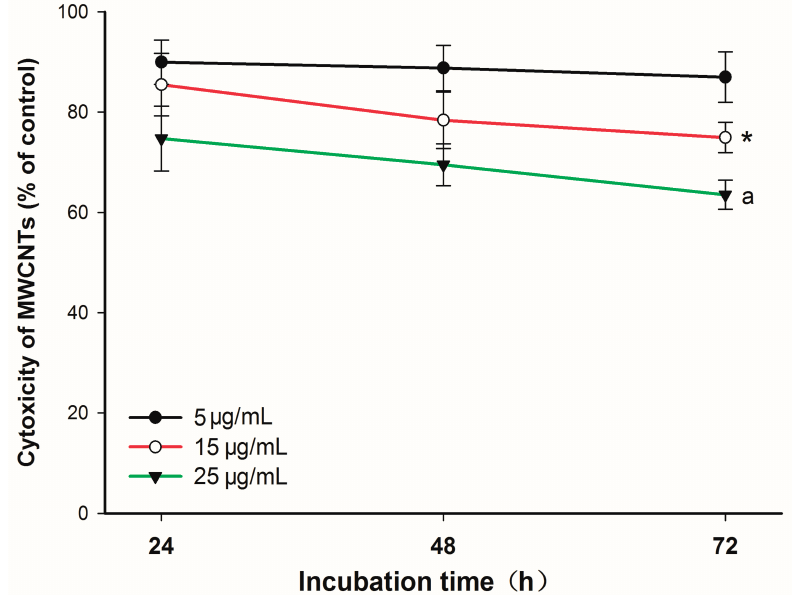
Figure 1. Cytotoxicity of carboxyl group-functionalized multi-walled carbon nanotubes (MWCNT-COOH) on cementoblasts at various concentrations after three days of incubation. Data are expressed as the mean ± SD. * p < 0.05, for 15 µg/mL MWCNT-COOH cells vs. control cells; a p < 0.001, for 25 µg/mL MWCNT-COOH cells vs. control